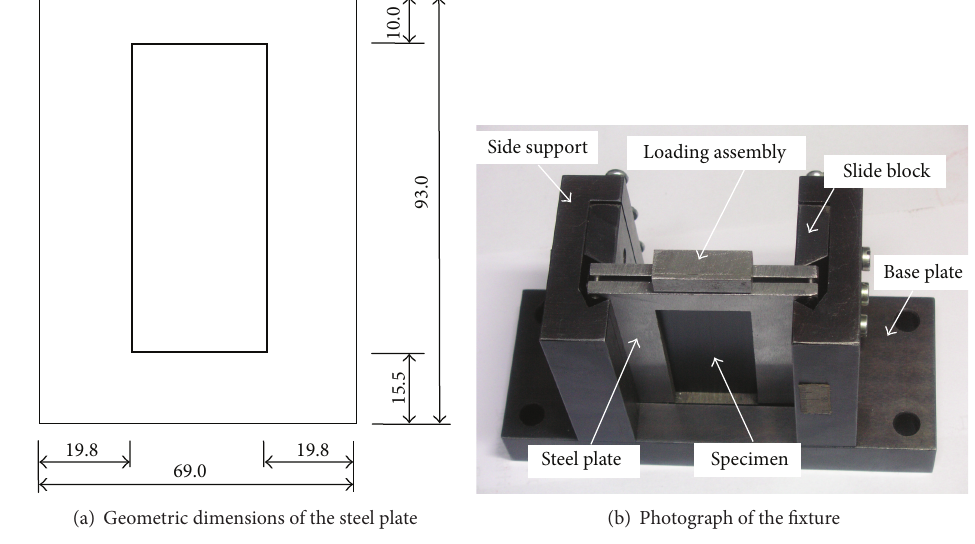
Figure 1: Compression testing device.